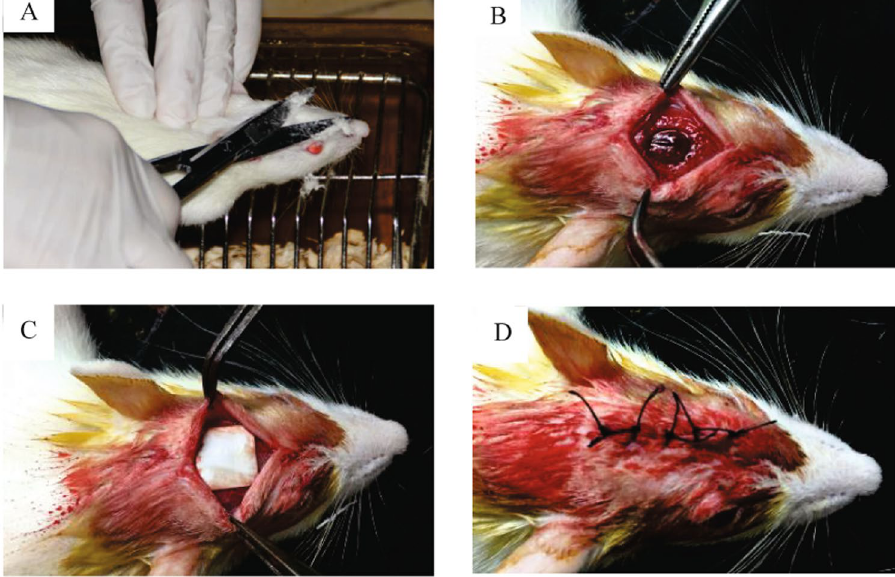
Figure 1. The animal experiment surgery procedure. ( A ) The preparation of SD rats for membrane implantation. ( B ) A complete defect was created on the cranium. ( C ) Implanting of the membrane and complete coverage of the defects. ( D ) Repositioning of the soft tissues and suturing layer by